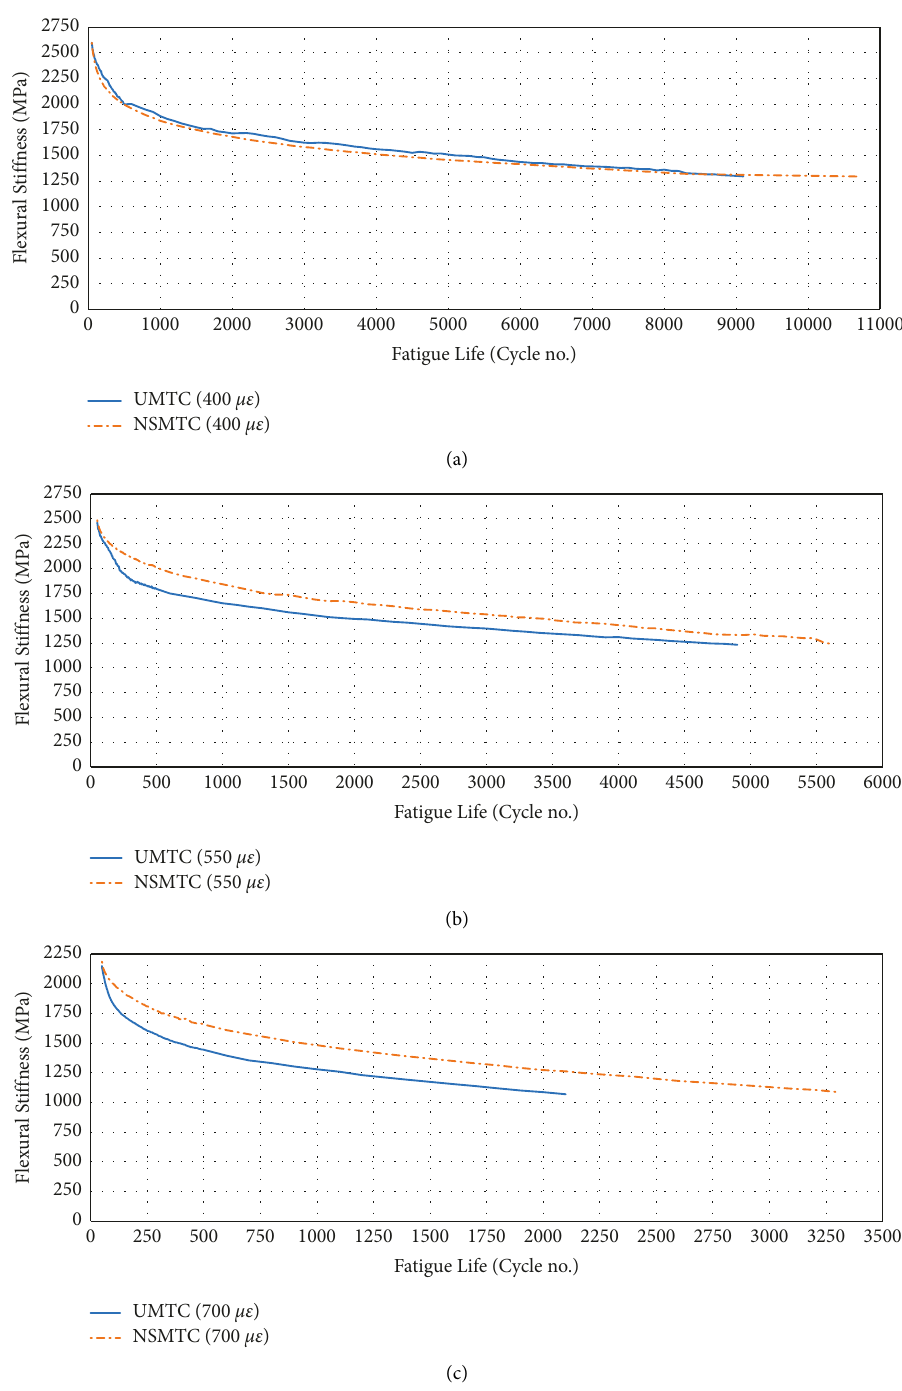
Figure 1: Changes in flexural stiffness against fatigue life of UMTC and NSMTC specimens at the strain levels of (a) 400, (b) 550, and (c) 700 με